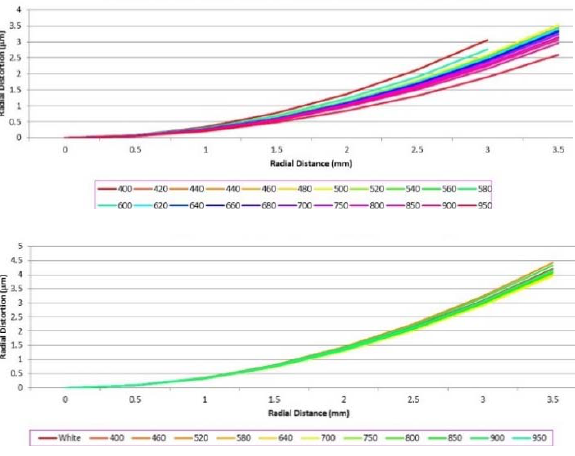
Figure 13. Variation in Tangential Distortion with Wavelength.